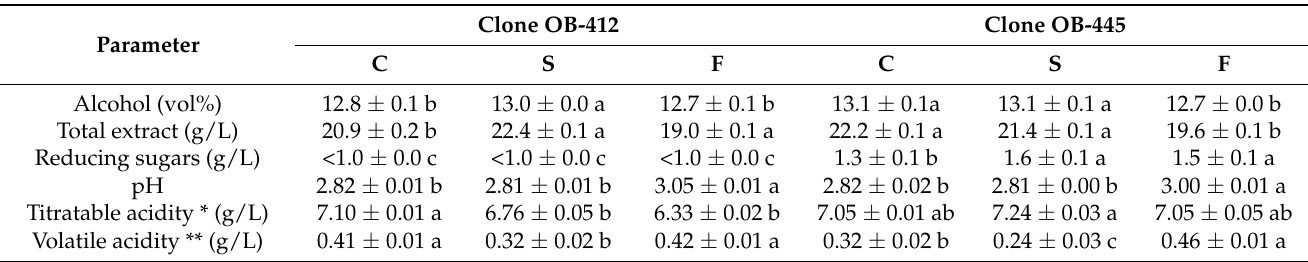
Table 1. Physicochemical parameters of Graševina wines produced of grape from two clones and subsequent alcoholic fermentation with three yeast strains, during vintage